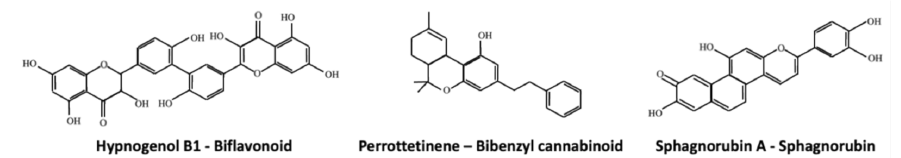
Figure 3. Examples of the biflavonoid Hypnogenol B1, the bibenzyl cannabinoid Perrottetinene and the Sphagnorubin